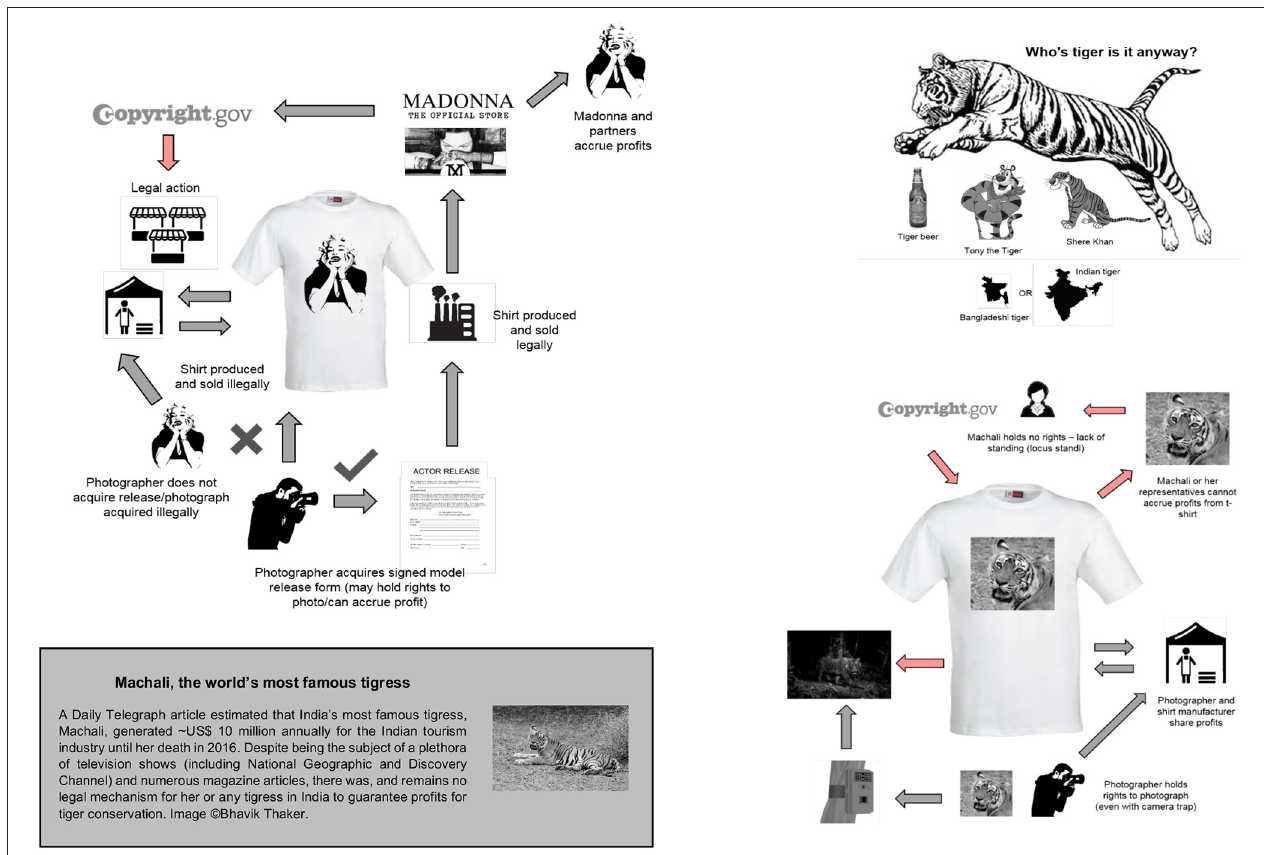
FIGURE 2 | A schematic flow diagram showing the fundamental differences in how a famous popstar can engage copyright laws in the USA, and how a high-profile member of a charismatic wildlife species (Machali the tigress) cannot, according to present-day